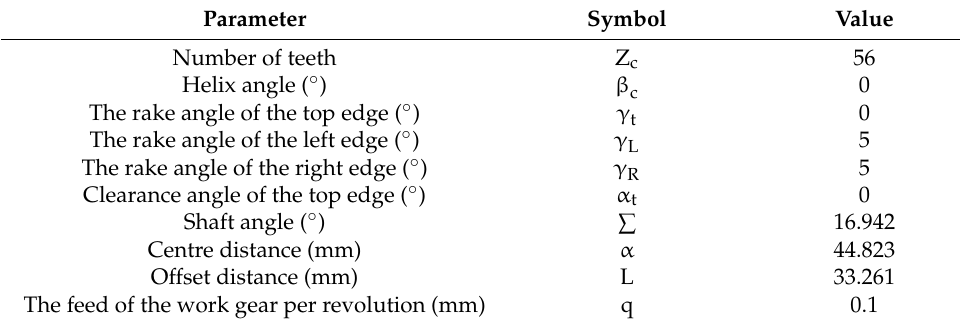
Table 2. Basic parameters of the skiving cutter and tool setting parameters.